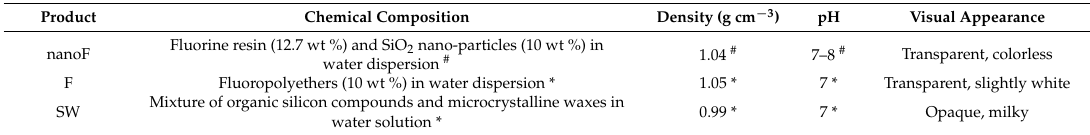
Table 1. Chemical composition and main details of the used products.